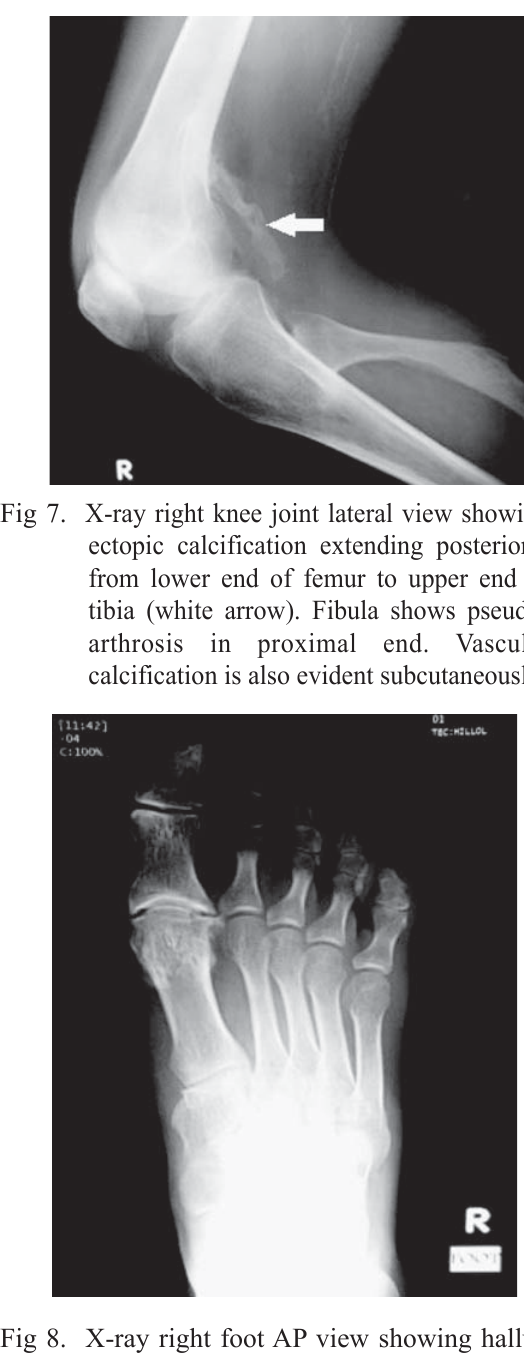
Fig 8. X-ray right foot AP view showing hallux valgus deformity and early degenerative changes of great